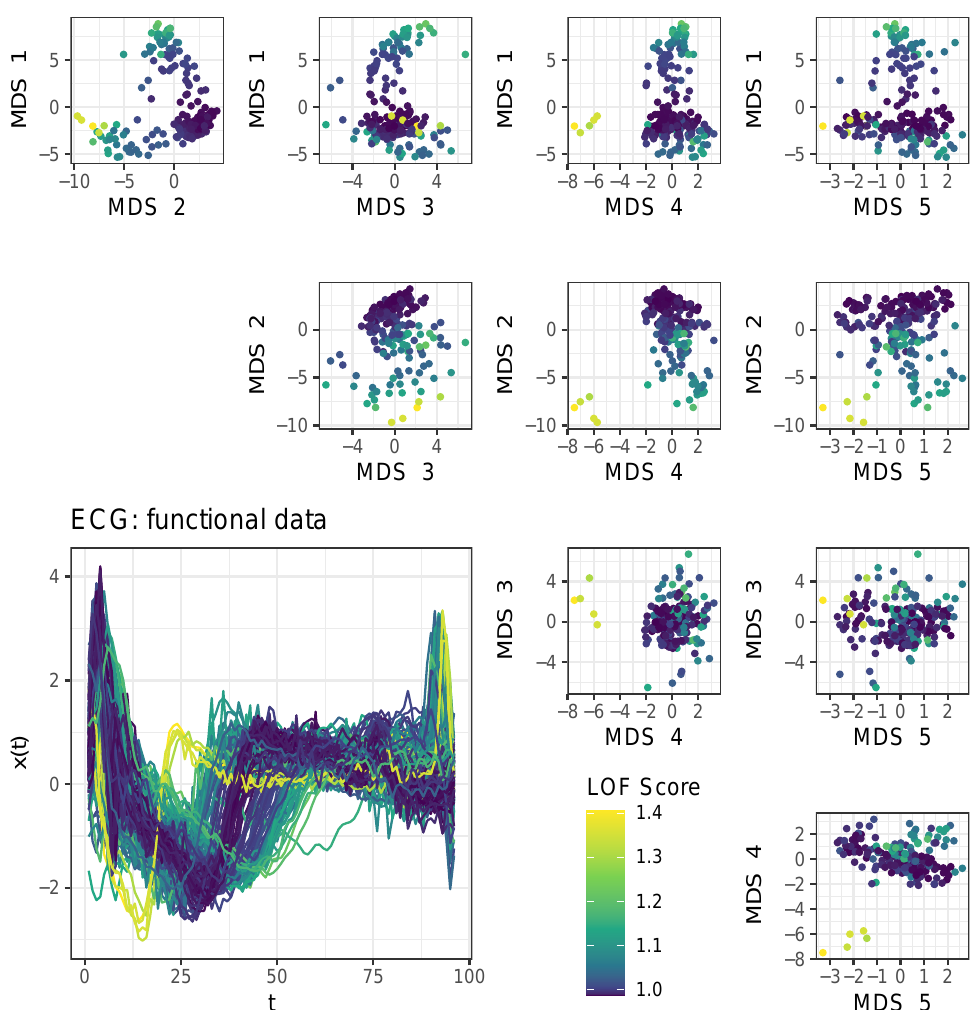
Figure 6. ECG data: scatterplot matrix of all 5 MDS embedding dimensions and curves; lighter colors for the higher LOF scores of 5D